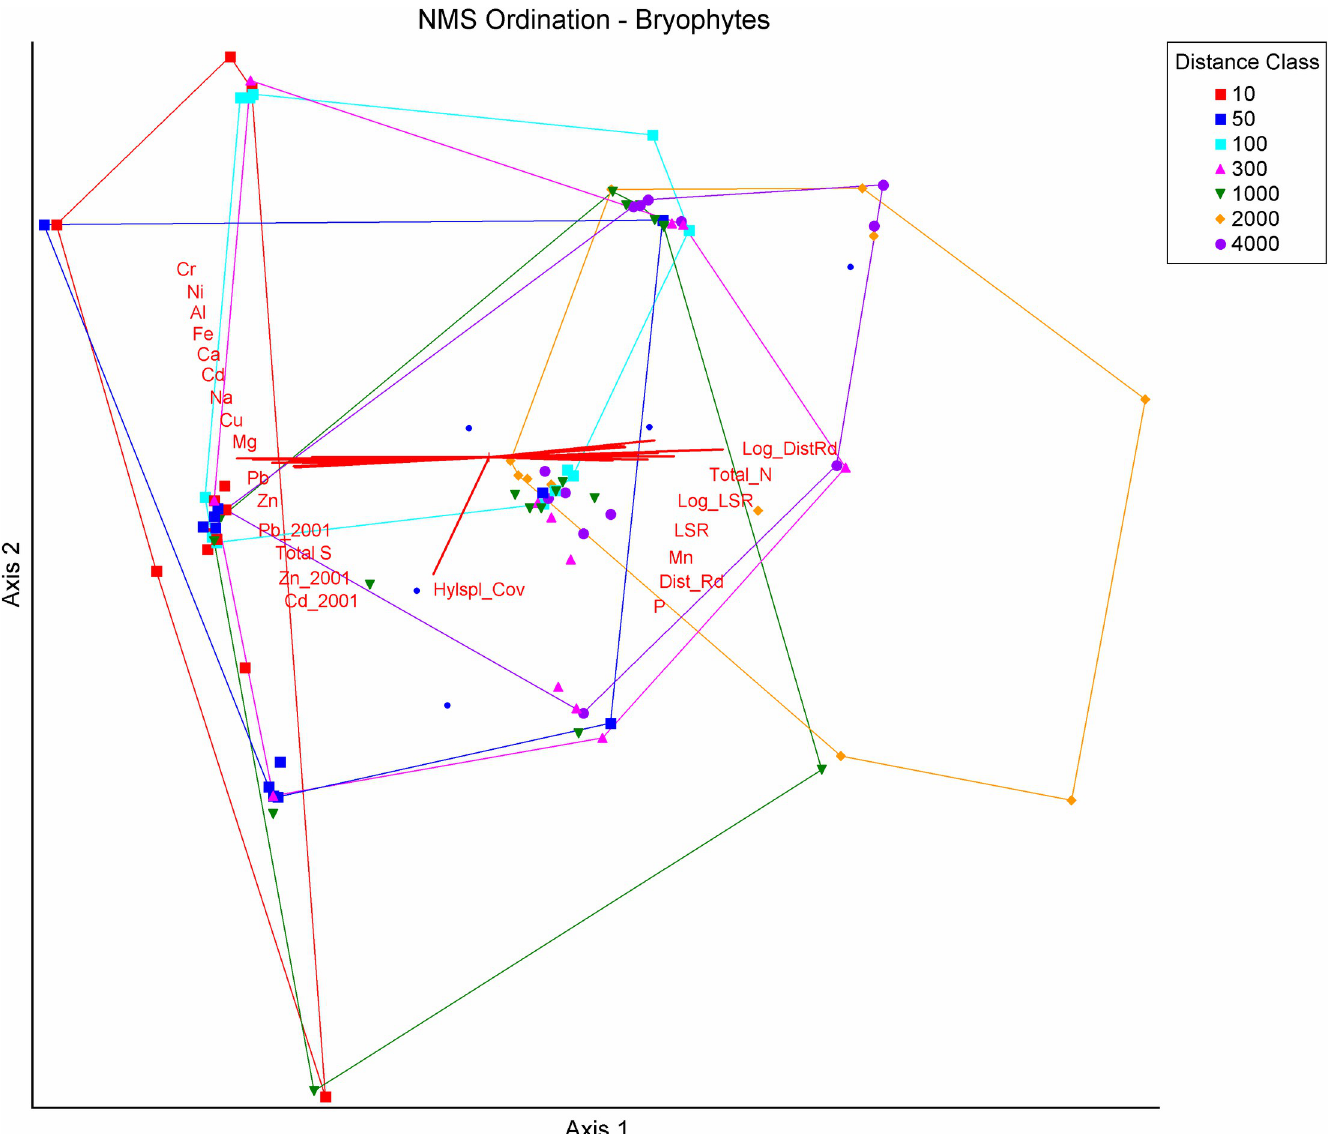
Fig 9. Nonmetric multidimensional scaling ordination of bryophytes on a matrix of 94 plots by 5 species groups along the DMTS haul road in Cape Krusenstern National Monument, Alaska. The ordination is overlain by vectors proportional to the strength of their correlation with ordination axes. Spearman r values for each variable are provided in Table 2. Convex hulls surround plots in each distance class. All two letter abbreviations are elements, and those followed by “_2001” are modeled values from 2001 sampling [18]. Mean elemental values were mg/kg in Hylocomium splendens tissue, dry weight, except % Total S and % Total N. Other abbreviations are: Total_S (Total sulfur), Hylspl_Cov ( H . splendens cover), LogDist_Rd (log 10 distance to the road), Total_N (Total nitrogen), Log_LSR (log 10 lichen species richness), LSR (lichen species richness), P (phosphorus), Dist_Rd (Distance to the road), P (phosphorus).